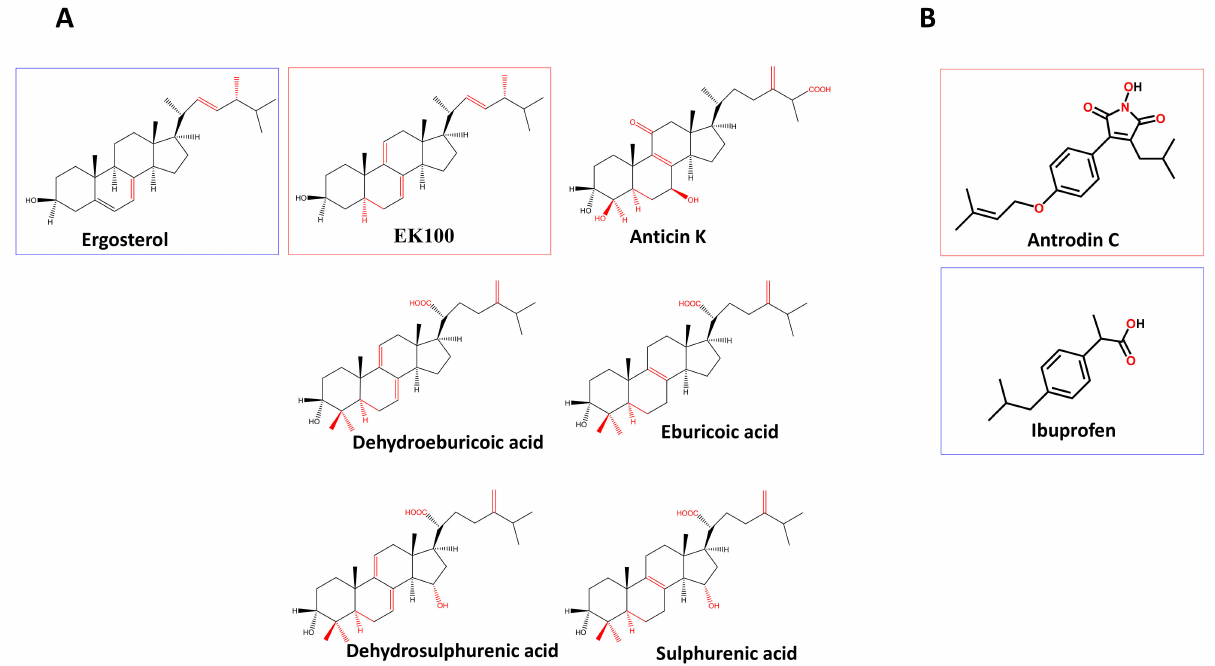
Figure 1. The structure of the compounds used in this study. ( A ) The structure of EK100 (Ergosta-7,9(11),22-trien-3 β -ol), ergosterol (Ergosta-5,7,22-trien-3 β -ol), anticin K (3 α ,4 β ,7 β -trihygroxy-4 α -methylergosta-8,24(28)-dien-11-on-26-oic acid), de- hydroeburicoic acid ((2 R )-2-[(3 S ,5 R ,10 S ,13 R ,14 R ,17 R )-3-hydroxy-4,4,10,13,14-pentamethyl-2,3,5,6,12,15,16,17-octahydro-1 H - cyclopenta[a]phenanthren-17-yl]-6-methyl-5-methylideneheptanoic acid), eburicoic acid ((2R)-2-[(3S,5R,10S,13R,14R,17R)- 3-hydroxy-4,4,10,13,14-pentamethyl-2,3,5,6,7,11,12,15,16,17-decahydro-1H-cyclopenta[a]phenanthren-17-yl]-6-methyl-5- methylideneheptanoic acid), dehydrosulfurenic acid ((2 R )-2-[(3 S ,5 R ,10 S ,13 R ,14 R ,15 S ,17 R )-3,15-dihydroxy-4,4,10, 13,14- pentamethyl-2,3,5,6,11,12,15,16,17-decahydro-1 H -cyclopenta[a] phenanthren-17-yl]-6-methyl-5-methylideneheptanoic acid), and sulfurenic acid ((2 R )-2-[(3 S ,5 R ,10 S ,13 R ,14 R ,15 S ,17 R )-3,15-dihydroxy-4,4,10,13,14-pentamethyl-2,3,5,6,7, 11,12,15,16,17- decahydro-1 H -cyclopenta[a]phenanthren-17-yl]-6-methyl-5-methyl-ideneheptanoic acid). ( B ) The structure of antrodin C (3-isobutyl-4-[4-(3-methyl-2-butenyloxy)phenyl]-1 H -pyrrol-1-ol-2,5-dione) and ibuprofen (isobutylphenyl-propionic acid). The red squares indicate the bioactive compounds and the blue squares indicate the control